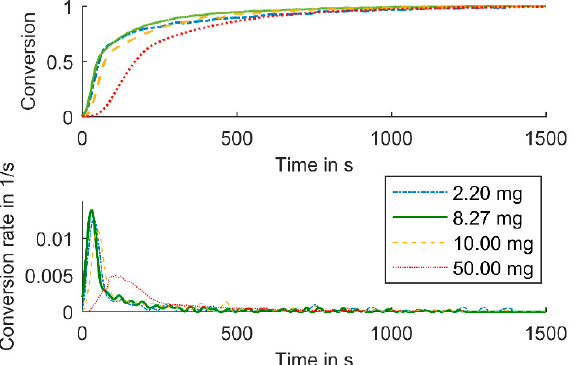
Figure 7. Impact of mass on conversions and conversion rates for oxidation of Cu 2 O at a 0.1 bar oxygen partial pressure and at 930 °C.